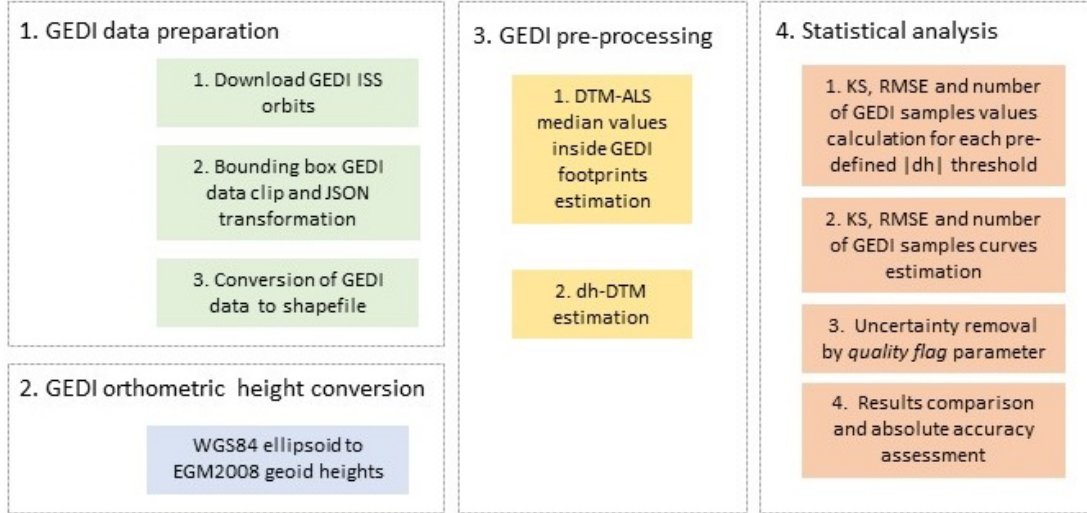
Table 1. GEDI metrics used in this study.